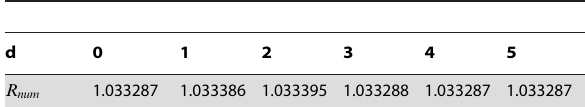
Table 2. Numerically obtained mean fitness R num for the parallel model with two overlapping mesa landscapes around two sequences, with Hamming distance d between central sequences, and with the maximal neutral mutation number n ~ 5 .